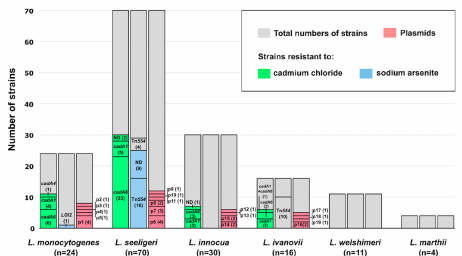
Figure 1. Resistance profiles, resistance determinants, and plasmids identified in Listeria spp. strains isolated from soil samples. Identified determinants conferring resistance to cadmium ( cadA1, cadA4, cadA6 ) and arsenic (Tn 554 -associated arsA , LGI2-associated arsA ); ND—undetermined resistance gene. The number of strains carrying identified resistance determinants and plasmids (representing 19 RFLP groups: p1–p19) is given in parentheses. The total number of strains within a species is indicated by the extent of the gray bar (n). Strains harboring Tn 554 -associated arsA genes, but not classified as resistant to arsenic, are indicated in